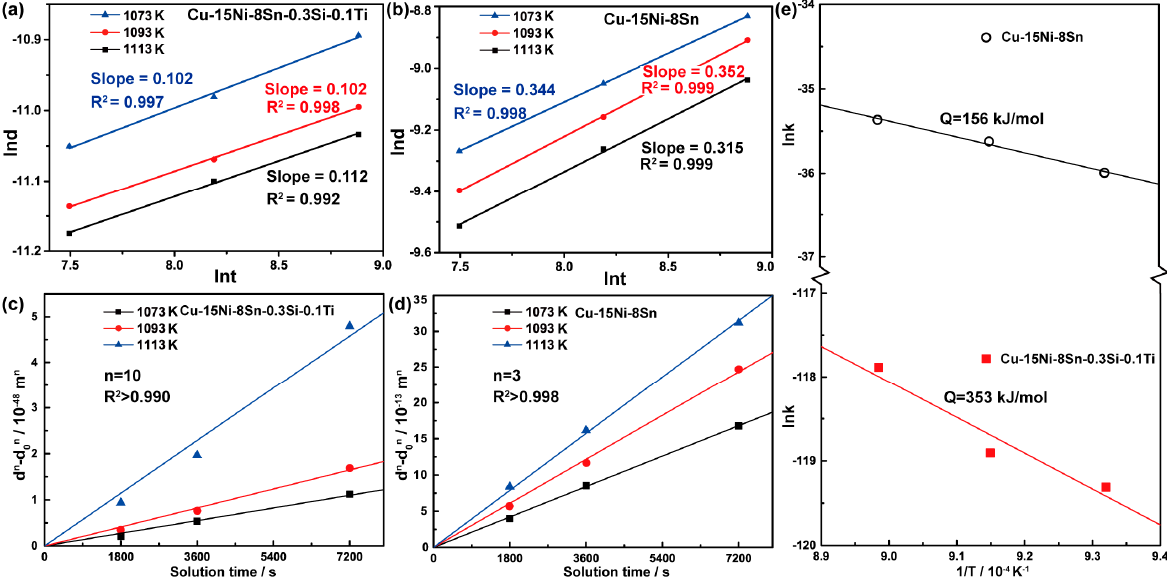
Figure 8. The grain growth kinetics analysis of the studied alloys during annealing treatment. ( a , b ) Linear fitted plots of lnd - lnt ; ( c , d ) curve fit plots of Equation (1) used to estimate grain growth exponents; ( e ) grain growth exponents as a function of the reciprocal of absolute temperature used to calculate the grain growth activation energy.